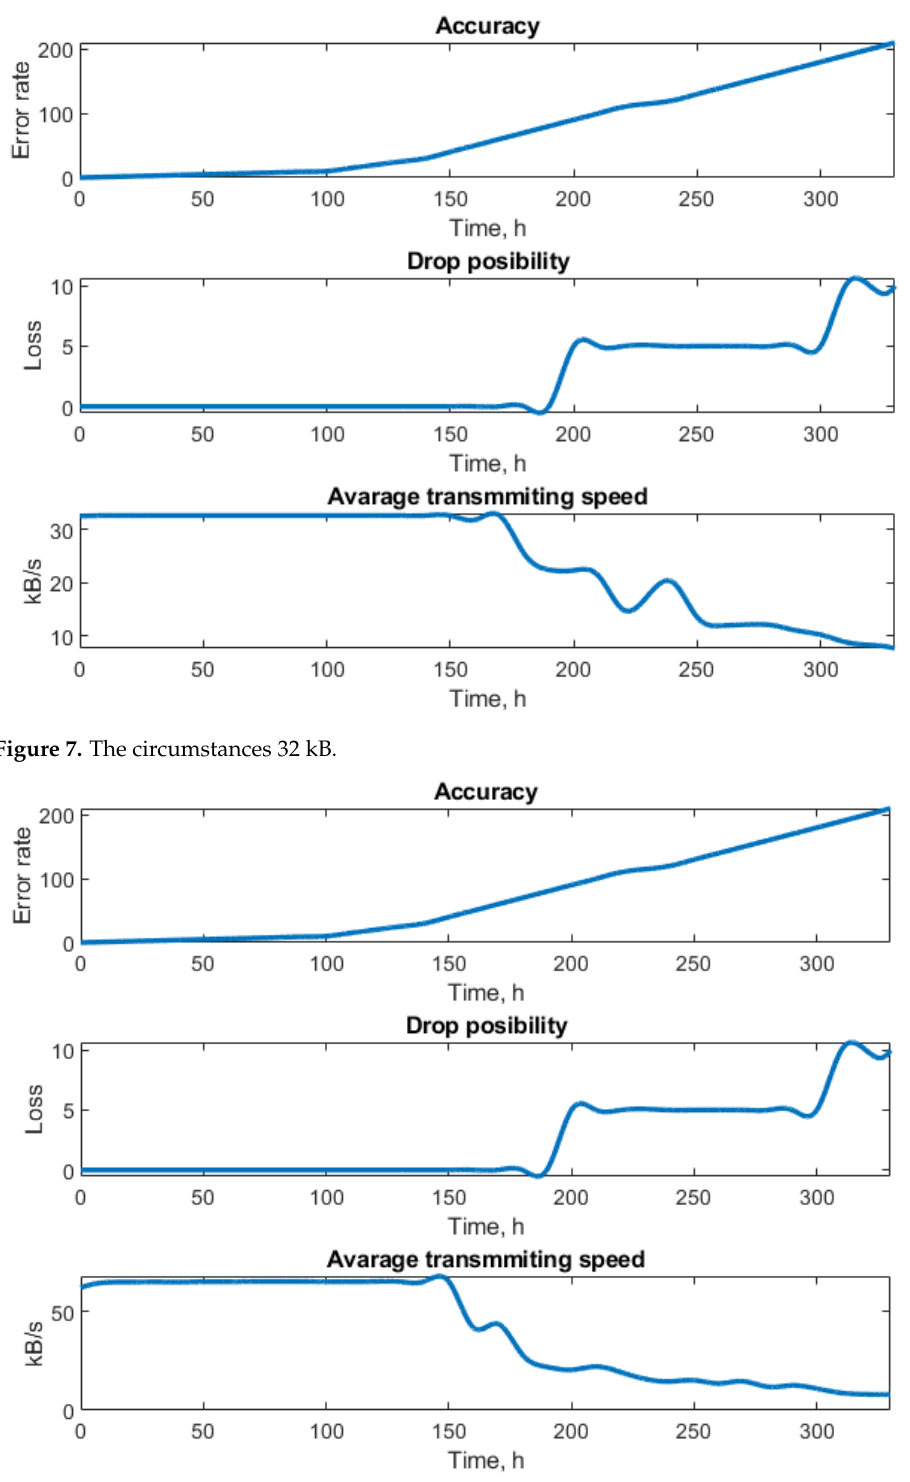
Figure 8. The circumstances 64